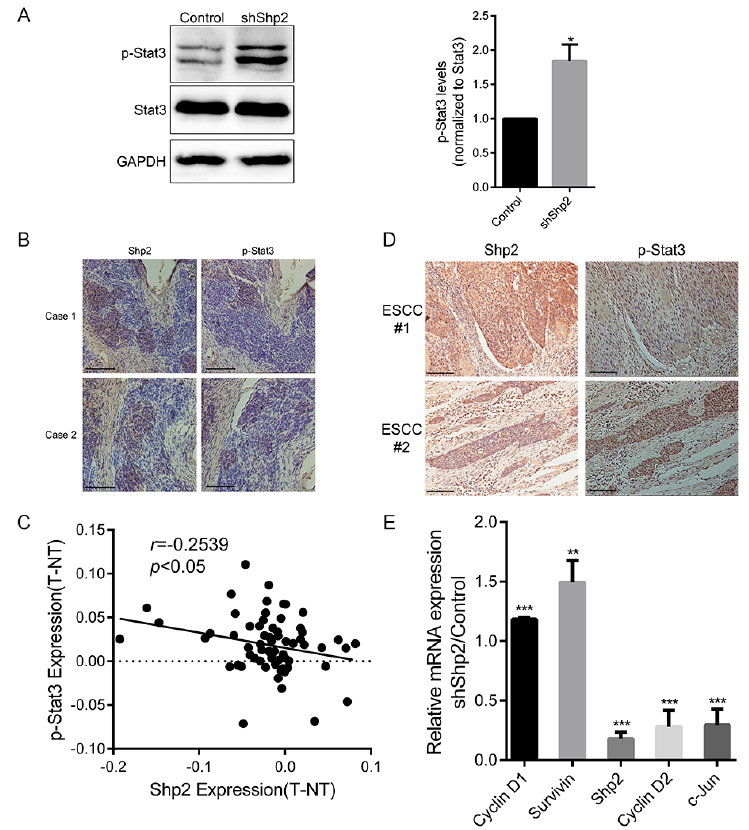
Figure 3. Shp2 knockdown promotes activation of Stat3 (signal transducer and activator of transcription 3) signaling. ( A ) p-Stat3 levels in shShp2 and control Eca109 cells were assessed by immunoblotting; ( B ) Stat3 phosphorylation negatively correlated with Shp2 expression in Xenograft tissues. Scale bar= 200 μ m; ( C ) Inverse correlations were found between p-Stat3 level and Shp2 expression in ESCC tissues by IHC staining; ( D ) Representative image of IHC staining of ESCC tissue. Scale bar= 200 μ m; ( E ) Relative mRNA expression of Cyclin D1, Survivin, Cyclin D2, c-Jun, and Shp2 in shShp2 or control cells was analyzed by real-time PCR. (* p < 0.05, ** p < 0.01, *** p < 0.001). To identify effector molecules responsible for proliferation increments, we measured potential target genes involved in cell proliferation. Cyclin D1 and Survivin, downstream molecules of Stat3, were upregulated (1.18 ± 0.01-folds, p < 0.001; 1.49 ± 0.18-folds, p < 0.01) upon Shp2 depletion in ESCC cells, while Cyclin D2 and c-Jun expression were attenuated (0.28 ± 0.14-fold, p < 0.001; 0.29 ± 0.14-fold, p < 0.001; Figure 3E). We supposed that Shp2 regulated Cyclin D1 and Survivin expression